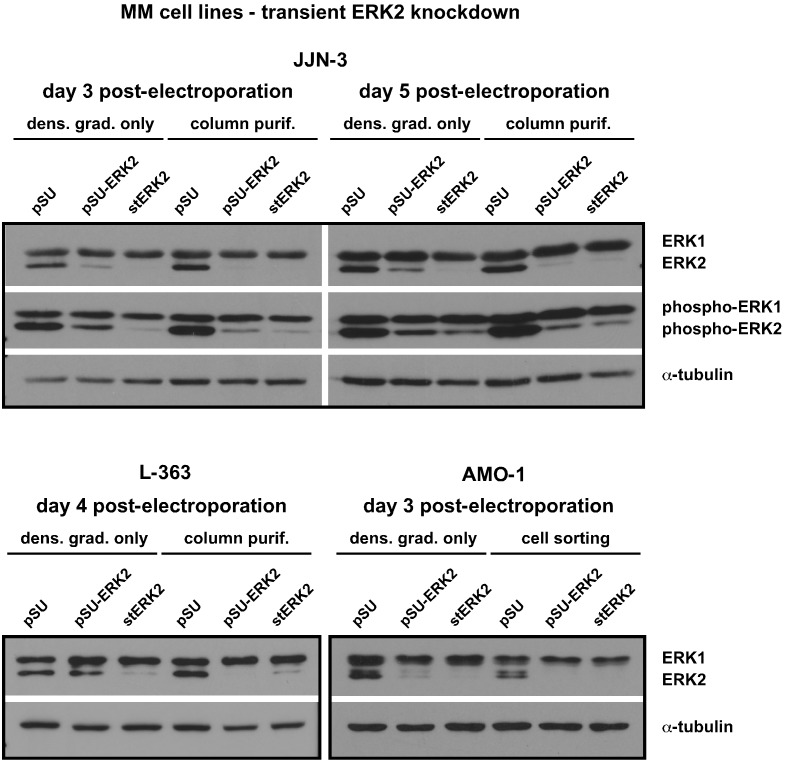
Knockdown efficiency in MM cells.Knockdown of ERK2 in different MM cell lines after transfection with either a short-hairpin expression vector (pSU-ERK2) or the “corresponding” target sequence synthesised as 25 bp stealth siRNA (stERK2; see Methods and [21]). At day 1 post-electroporation half of the transfected culture was subjected to the column purification method (also see Fig. 1b)–e)) (resp. cell sorting for AMO-1 cells) and the other half to debris removal only (also see Fig. 1f)). Cells were harvested for Western blotting at the times indicated. Empty pSUPER vector (pSU) transfected cells served as controls. The blots show that the ERK2 knockdown efficiency for stealth siRNA is virtually identical between cells that only underwent debris removal and those that were subjected to the column purification procedure. ERK2 knockdown using the short-hairpin expression vector was less efficient in debris-removal-only samples compared with their cognate column purification complements (see JJN-3, L-363). Representative experiments (JJN-3: n = 3; L-363: n = 2, AMO-1: n = 2) are shown. Anti-ERK1/2 antibody: CST.